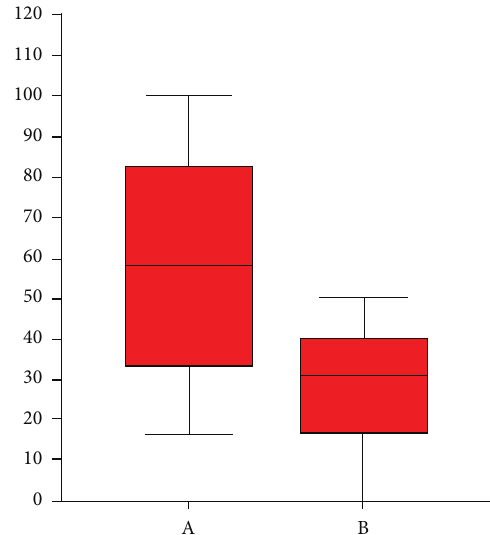
Figure 4: Percentage shown by box plots of changes before and after treatmentoftheIGAscoreinthetwogroupsAandB;thedifferences are evaluated using the Mann-Whitney test ( 𝑃 = 0.003 ).